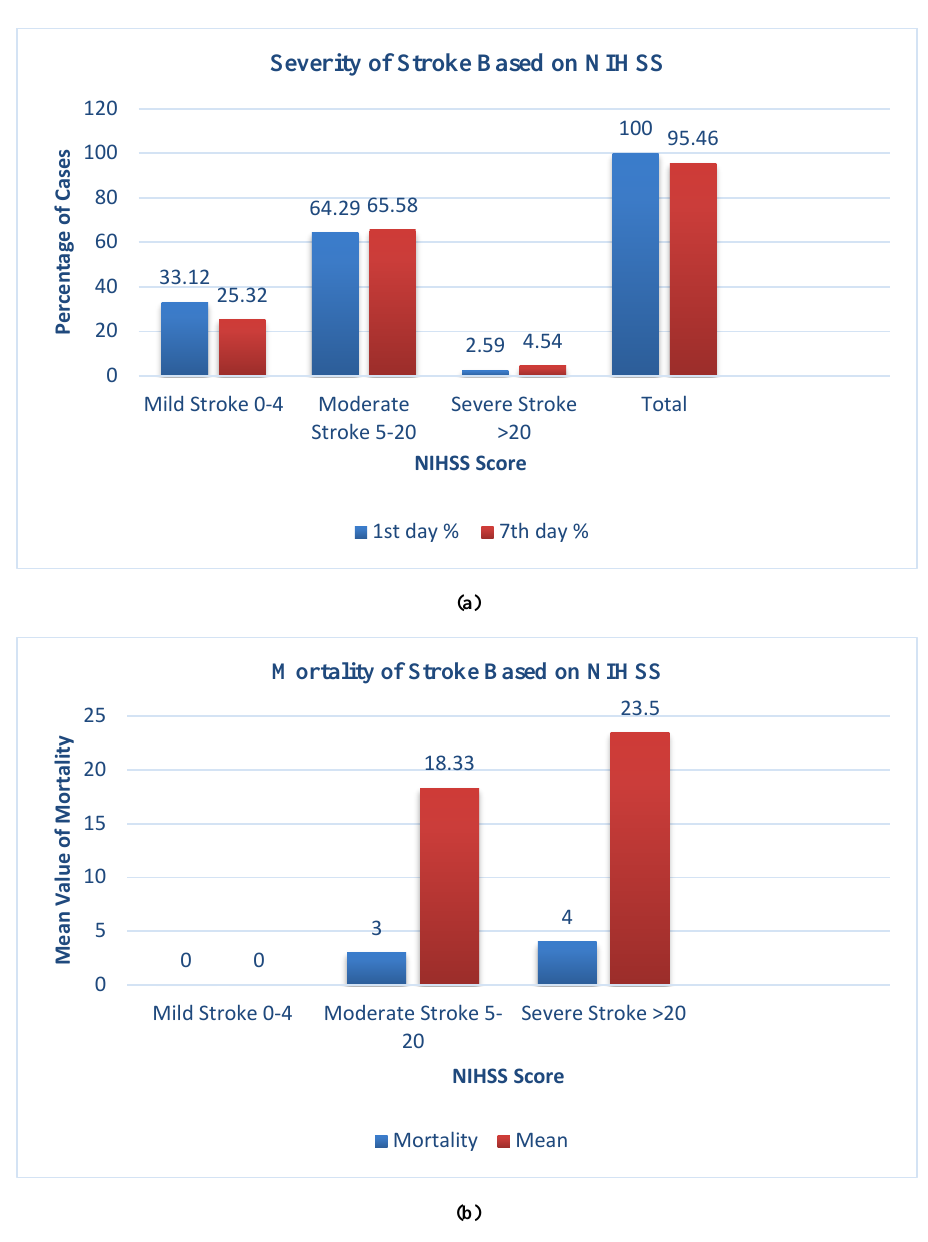
Fig. 4. (a) Severity of stroke based on NIHSS, (b) Mortality of stroke based on